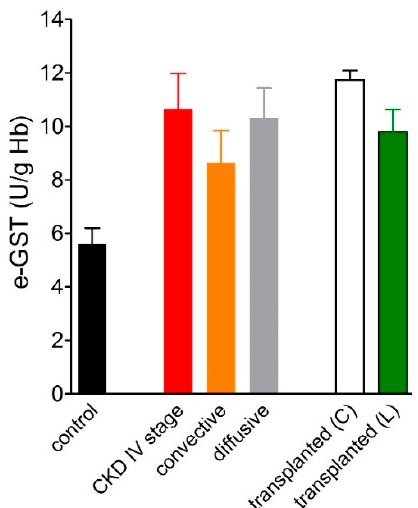
Figure 9. Erythrocyte glutathione transferase (e-GST) activity in transplant patients. e-GST activity of transplant patients from cadaver (C) (white bar) and living donors (L) (green bar) compared to healthy subjects (control) (black bar), CKD stage IV patients (red bar) and patients under two different dialysis techniques convective (orange bar) and diffusive (grey bar) (modified from Reference [49] ).